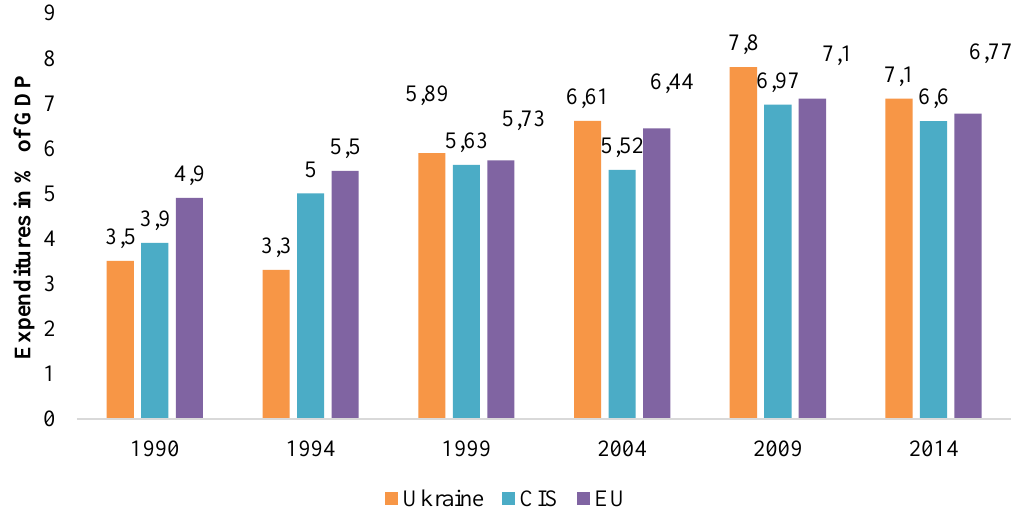
Fig. 1. Study of the dynamics of expenditures (%) on health care from the country's GDP by indicative analysis points (WHO